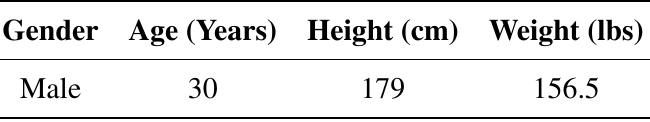
Table 2. User’s preferences and